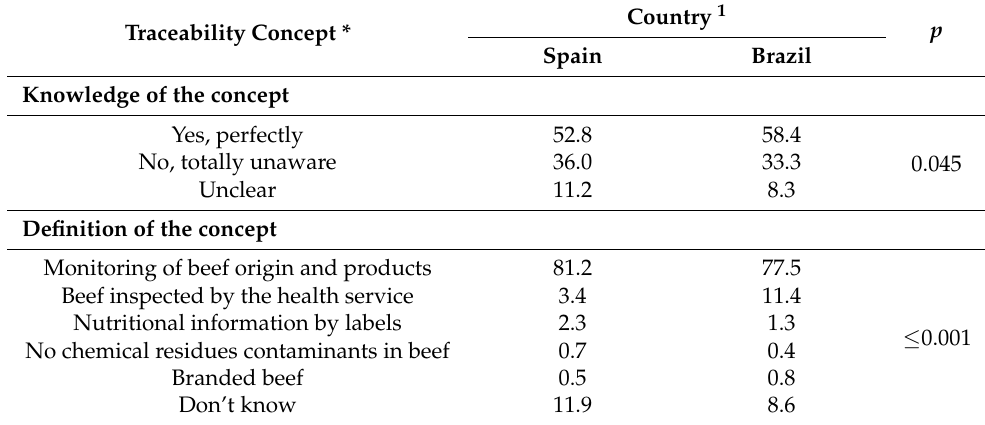
Table 1. Knowledge and definition of the traceability concept for Spanish and Brazilians consumers. Traceability Concept